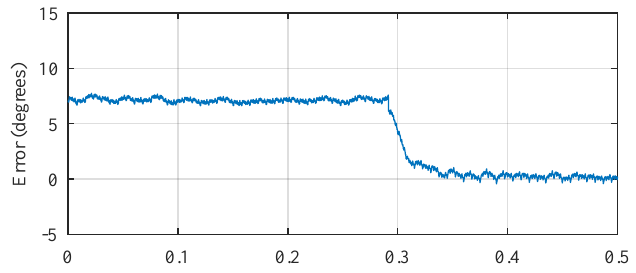
Figure 14. Angle compensation for the motor running at 200 rpm.